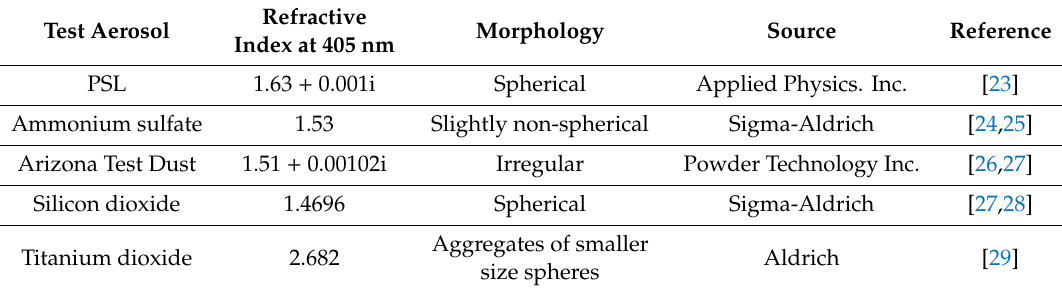
Table 1. Properties of tested aerosol